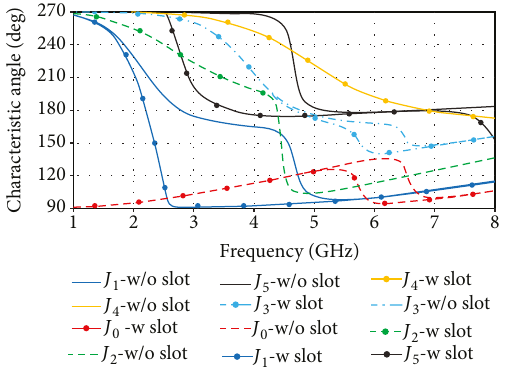
Figure 5: Comparison of the characteristic angle associated to the fi rst six CM of the patch antenna over a ground plane with and without